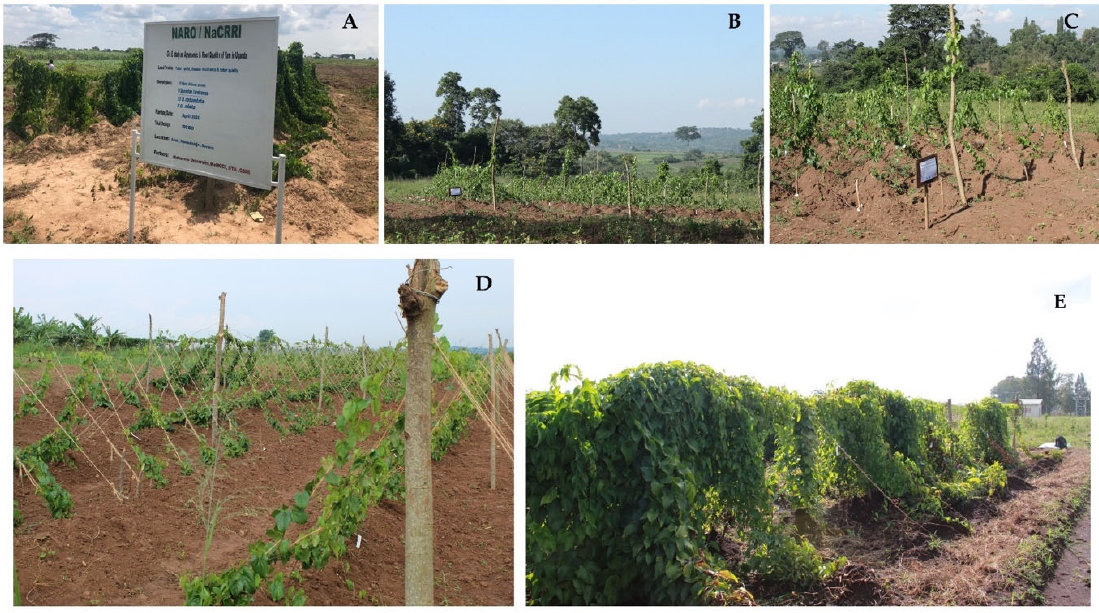
Figure 1. Pictures of yam trials at three experimental sites. ( A ) = Serere; ( B – D ) = Namulonge; ( E ) = Arua. Table 2. Geographical characteristics of environments for the genotype − by − environment interaction